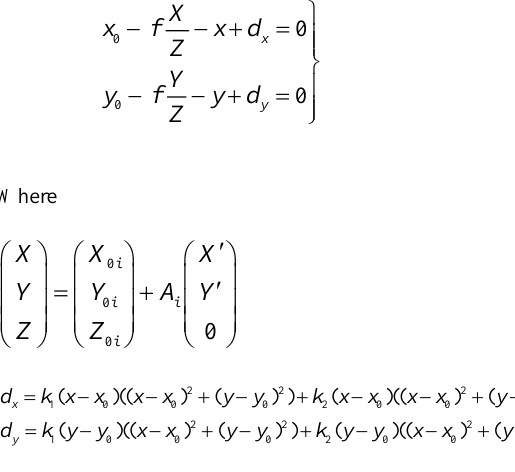
Table 1 Estimation of the accuracy of determining the camera